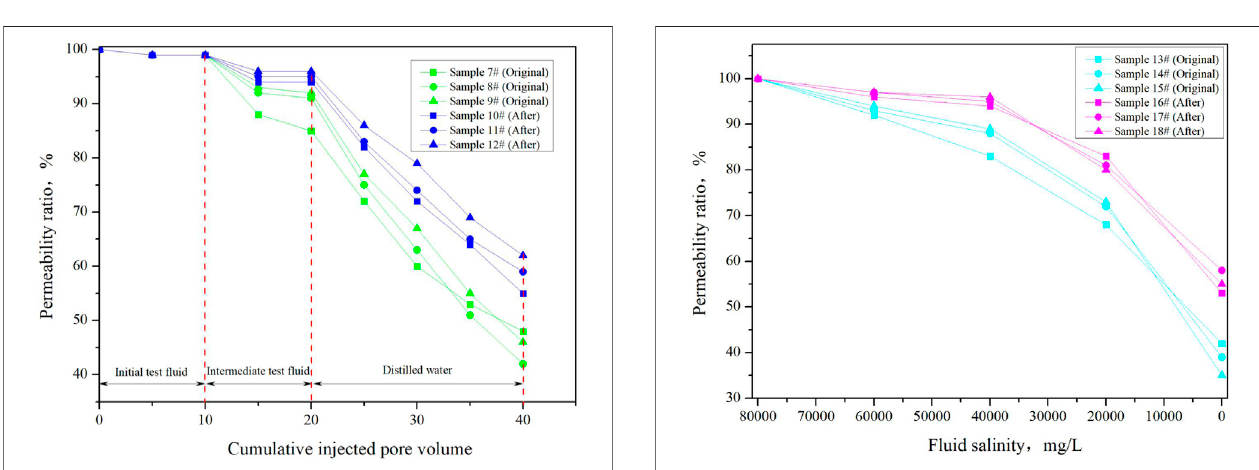
FIGURE 9 | Effect of supercritical CO 2 on water sensitivity. FIGURE 10 | Effect of supercritical CO 2 on salinity